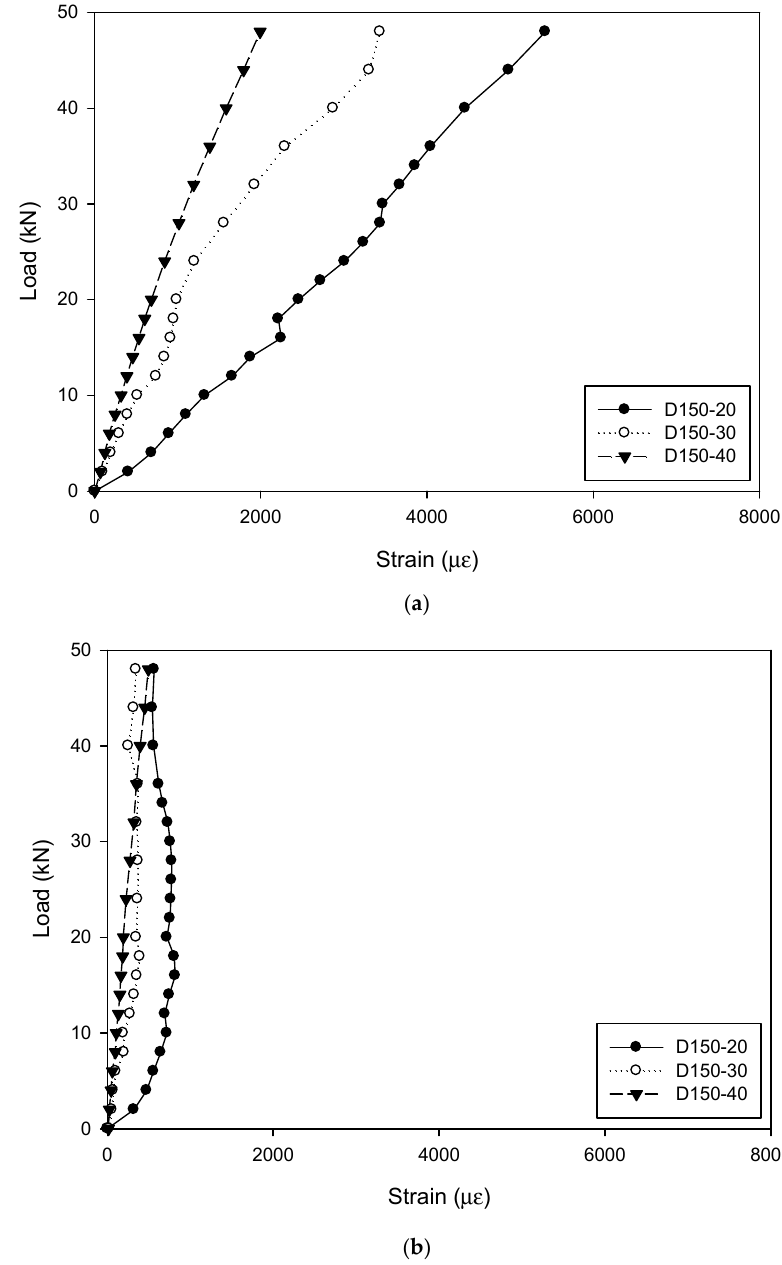
Figure 7. Strains of specimens with different dimensions of cross arms: ( a ) Strain on the GFRP tube at the corner of the cross arm; ( b ) strain on the GFRP tube in the middle of the cross arm.